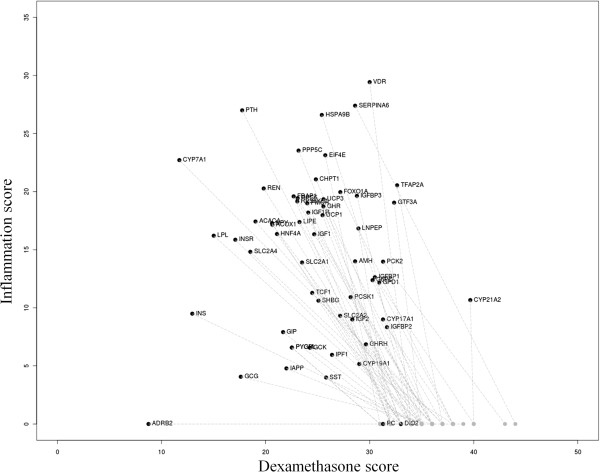
Influence of dexamethasone and inflammation on IR genes that have a high score with dexamethasone (>25)and a low score with inflammation (<25). The direct score of these genes with dexamethasone and inflammation are shown in grey. The literature neighbor score for these genes, by also including the relations of dexamethasone and inflammation with genes to which the gene is connected in the network, are shown in black. The grey arrows indicate the migration of the gene from a direct score to a literature neighbor score.